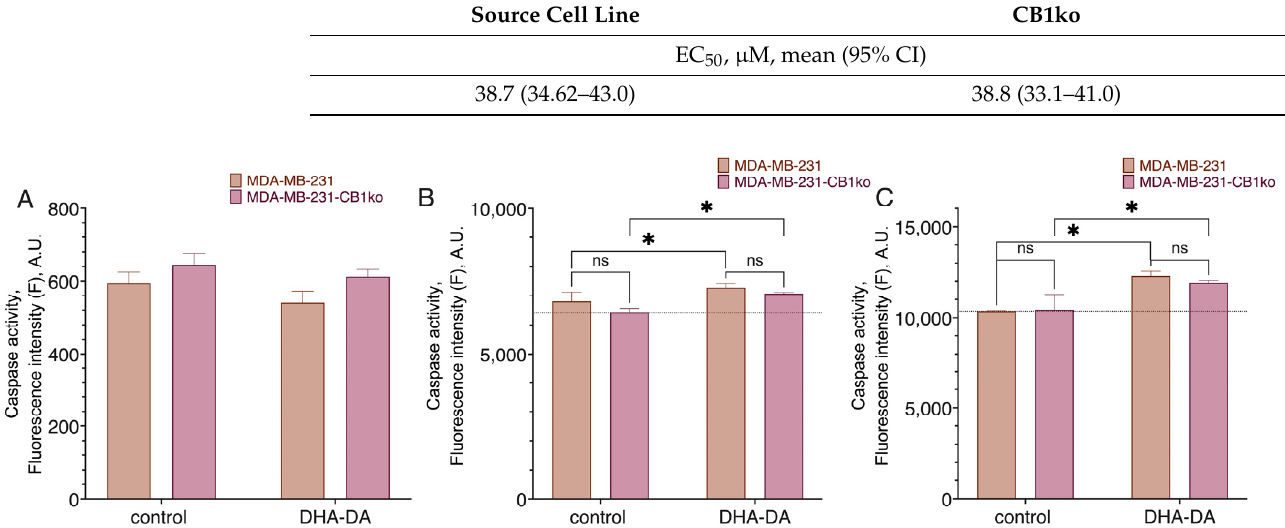
Figure 1. The effect of CB1 knockout on DHA ‐ DA cytotoxicity. Incubation 24 h, MTT test, mean±standard deviation ( n = 7 experiments).